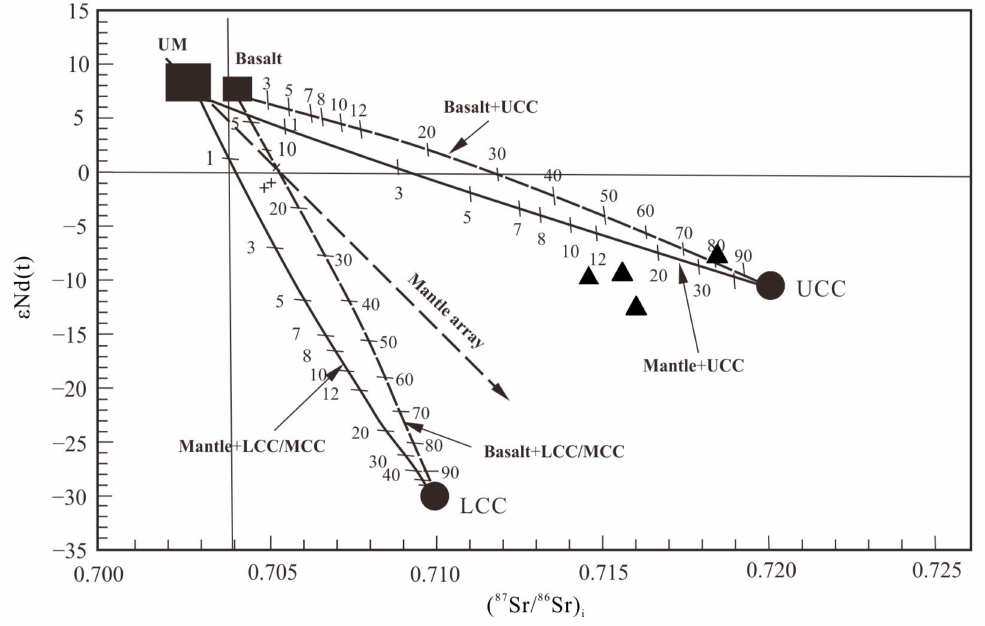
Figure 8. ε Nd (t)–( 87 Sr / 86 Sr) i diagram for biotite granite inthe Gaudeanmus area, Namibia (after Janh etal. [45]). UM—upper mantle peridotites, UCC—upper continental crust, MCC–LCC—middle to lower crust data of middle